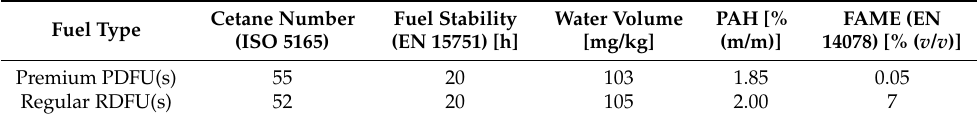
Table 2. Measured parameters of summer fuels used in this study.